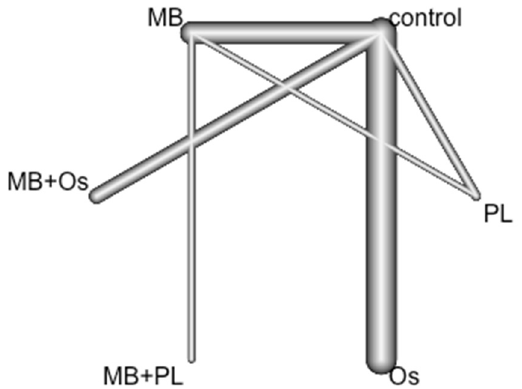
Figure 4. NETWORK plot of GTR techniques. Node size is proportional to the number of participants randomized to that technique, and the edge width is proportional to number of trials comparing two techniques.